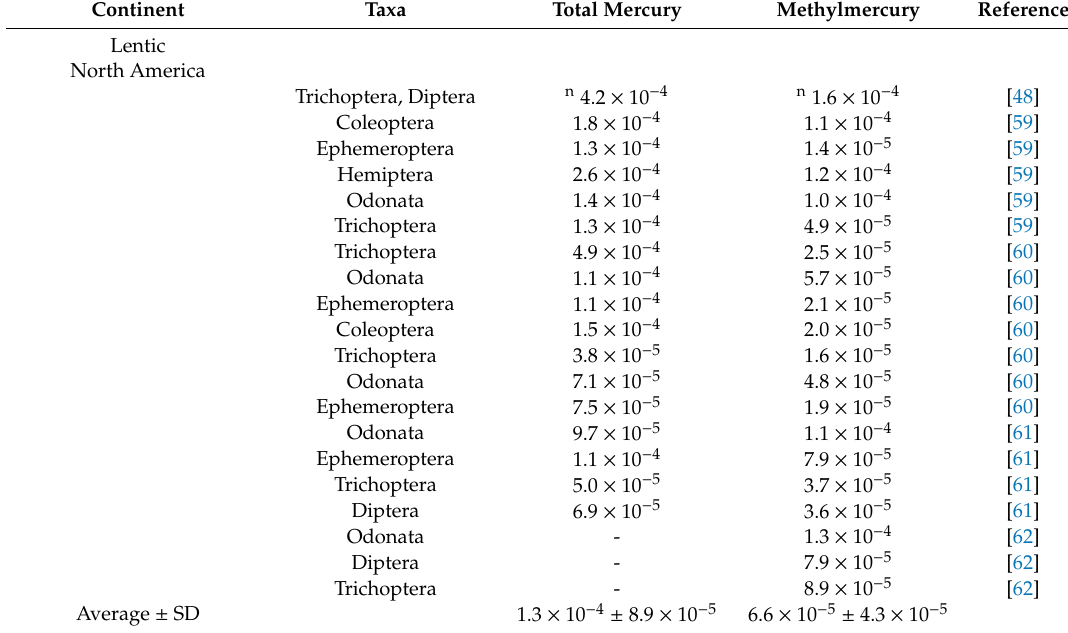
Table 4. Total mercury (Hg, mg g − 1 of dry mass) and methylmercury (MeHg, mg g − 1 ) in emergent aquatic insects in lakes. ‘Community’ denotes instances where whole taxa values are reported. Average and coe ffi cient of variation in bold represents the grand average that was used to calculate emergence for Africa, Asia, Australia,